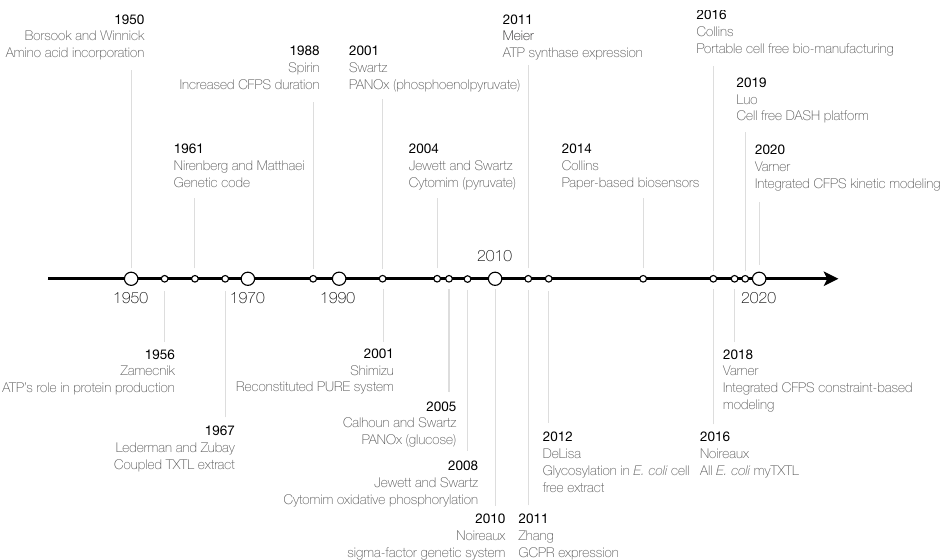
Figure 1. Time line for milestones in the evolution of cell-free systems since 1950 until now. Abbreviations: cell-free protein synthesis (CFPS), G-coupled protein receptor (GCPR), transcription and translation (TXTL), CFPS system energized by PEP (PANOx), DNA-based Assembly and Synthesis of Hierarchical (DASH), commercially available E. coli cell free extract (myTXTL, Arbor